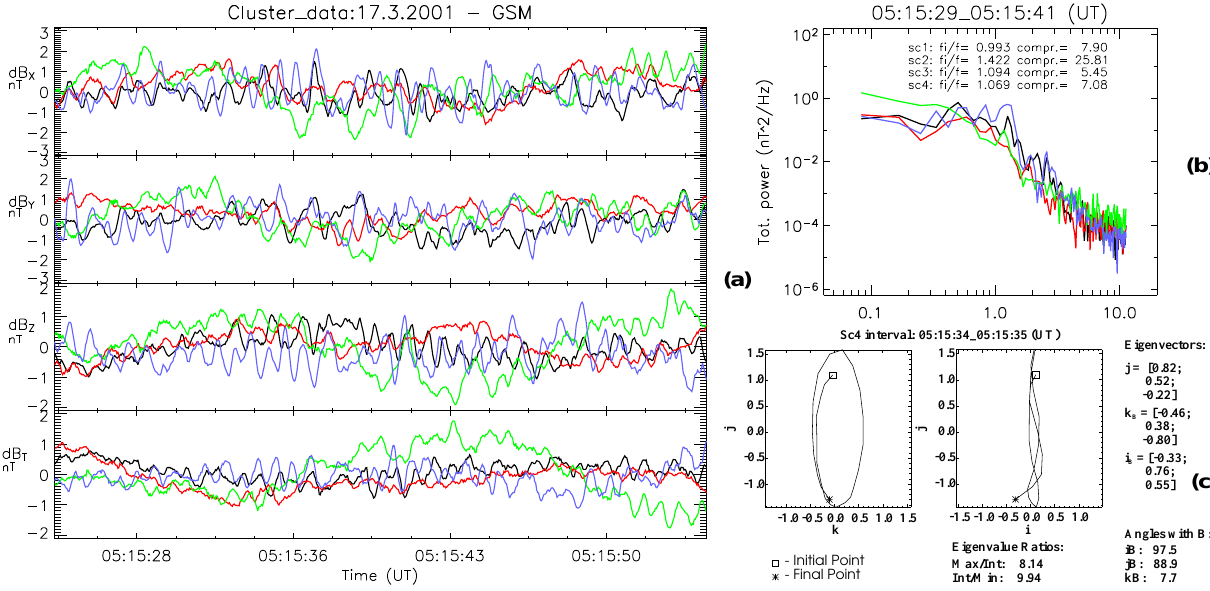
Fig. 7. (a) De-trended magnetic field components between 05:15:20–05:15:58 UT for all Cluster spacecraft (left). The upper right-hand side shows the total power in the fluctuations at 05:15:29–05:15:41 UT for all 4 spacecraft. The magnetic field hodogram between 05:15:34– 05:15:35 UT observed by SC4 is plotted in panel (c) . Other details are as in Fig.